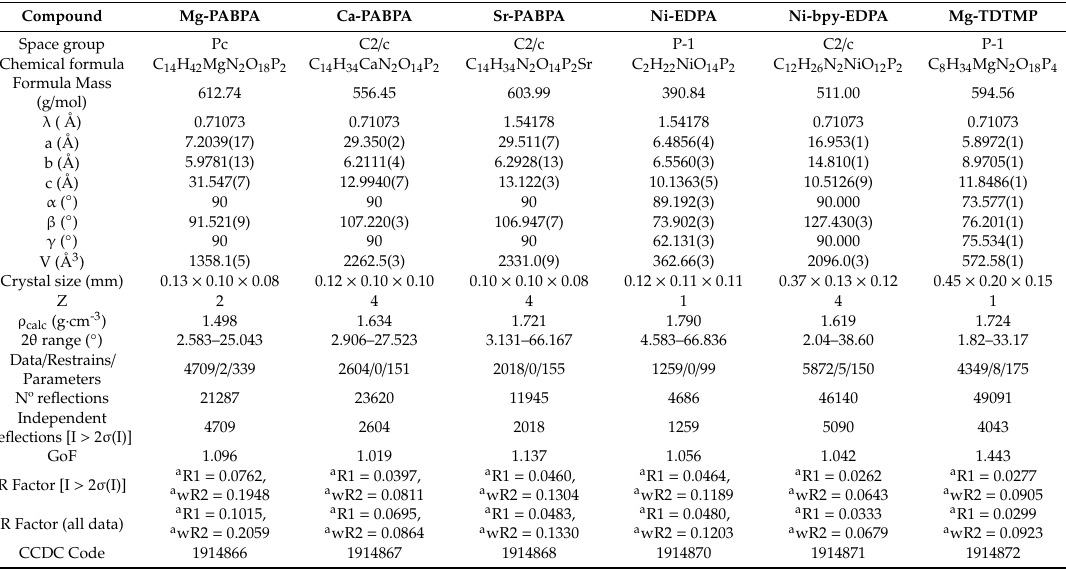
Table 1. Selected crystallographic data for all